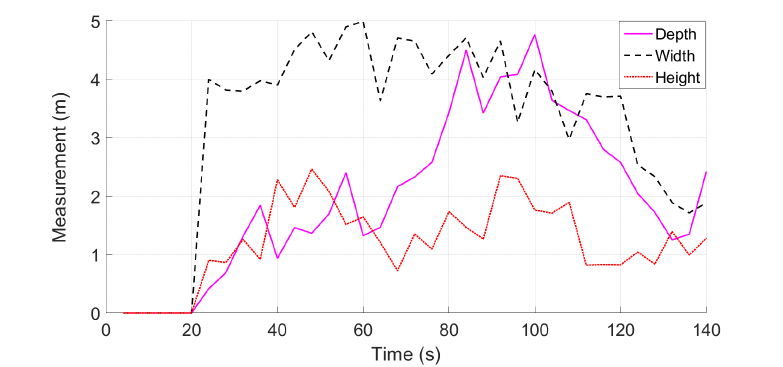
Figure 34. Temporal evolution of the width, height, and